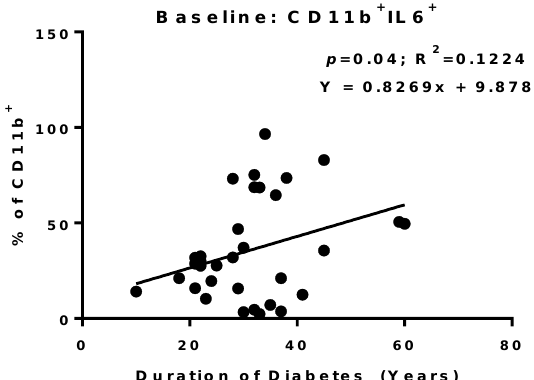
10 of 20 Table 5. Cytokine expression of PBMCs from aPDR vs. mNPDR patients in different culture condi- tions. Cytokine